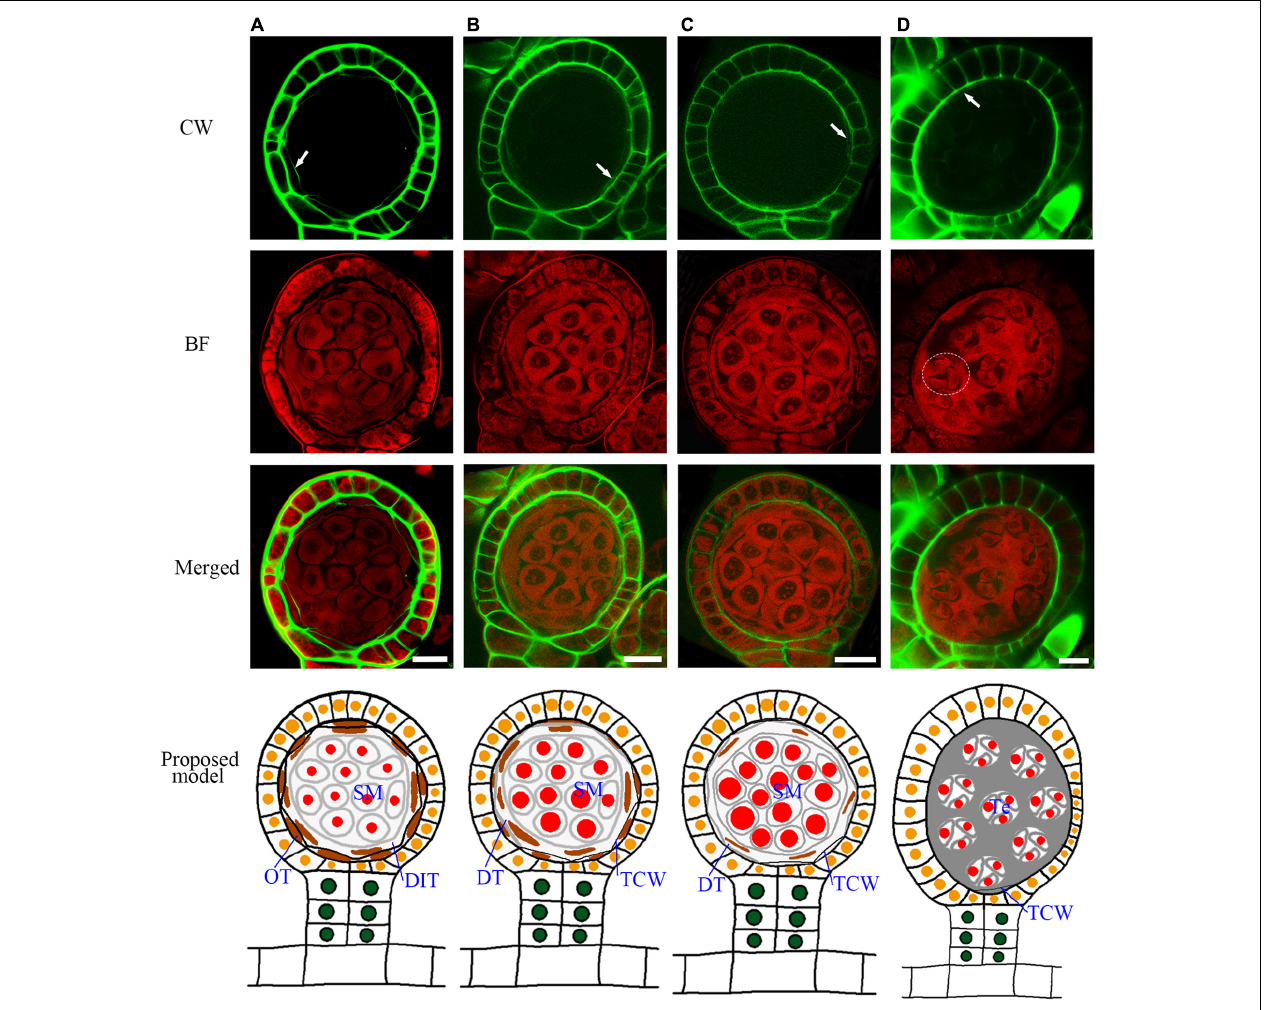
FIGURE 5 | Sporangium development with tetrad formation. The spore mother cells undergo meiosis to form the tetrads, and the cell wall of the tapetum is degraded. (A) The spore mother cell wall has been completely degraded. The cell wall of the inner tapetum degradation. Arrow points to the wall of the outer tapetal cell. (B,C) The inner tapetum cells become hypertrophy. Arrow points to the wall of the outer tapetal cell. (D) Tetrads are formed while the inner tapetum cells are almost disintegrated. Arrow points to the wall of the outer tapetal cell. The dotted circle points to the area of one tetrad. CW signals are colored green. BF signals are colored red. Scale bar = 20 µ m. (A–D) Proposed models are shown on the right of each inset. DIT, degraded inner tapetum cell; OT, outer tapetum cell; SM, spore mother cell; Te, tetrad; TCW, tapetum cell